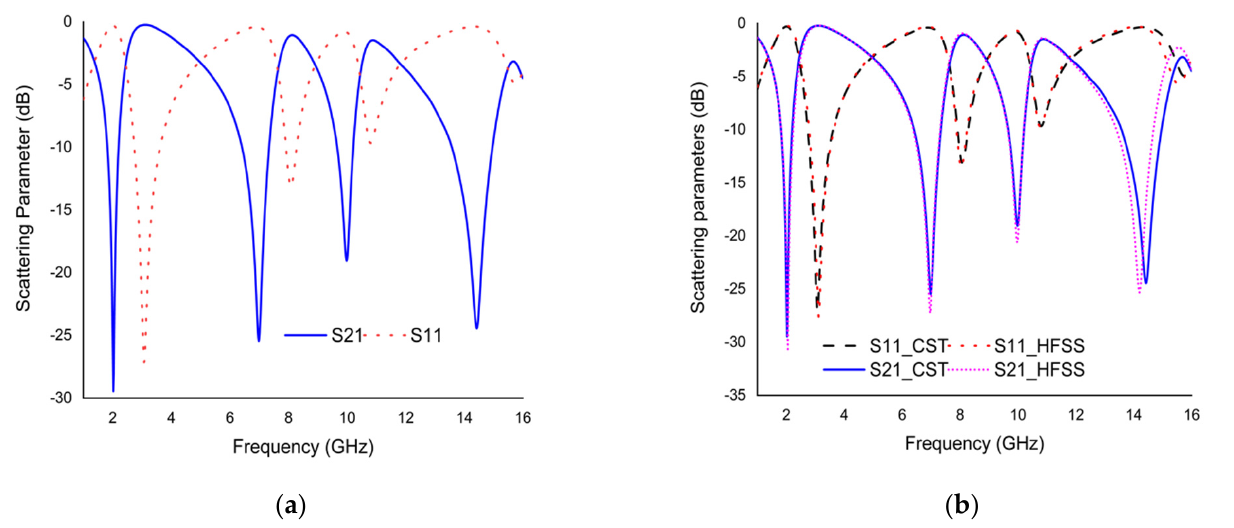
Figure 8. The graph for ( a ) S 11 vs. S 21 using CST simulator, ( b ) S 11 vs. S 21 using CST and HFSS